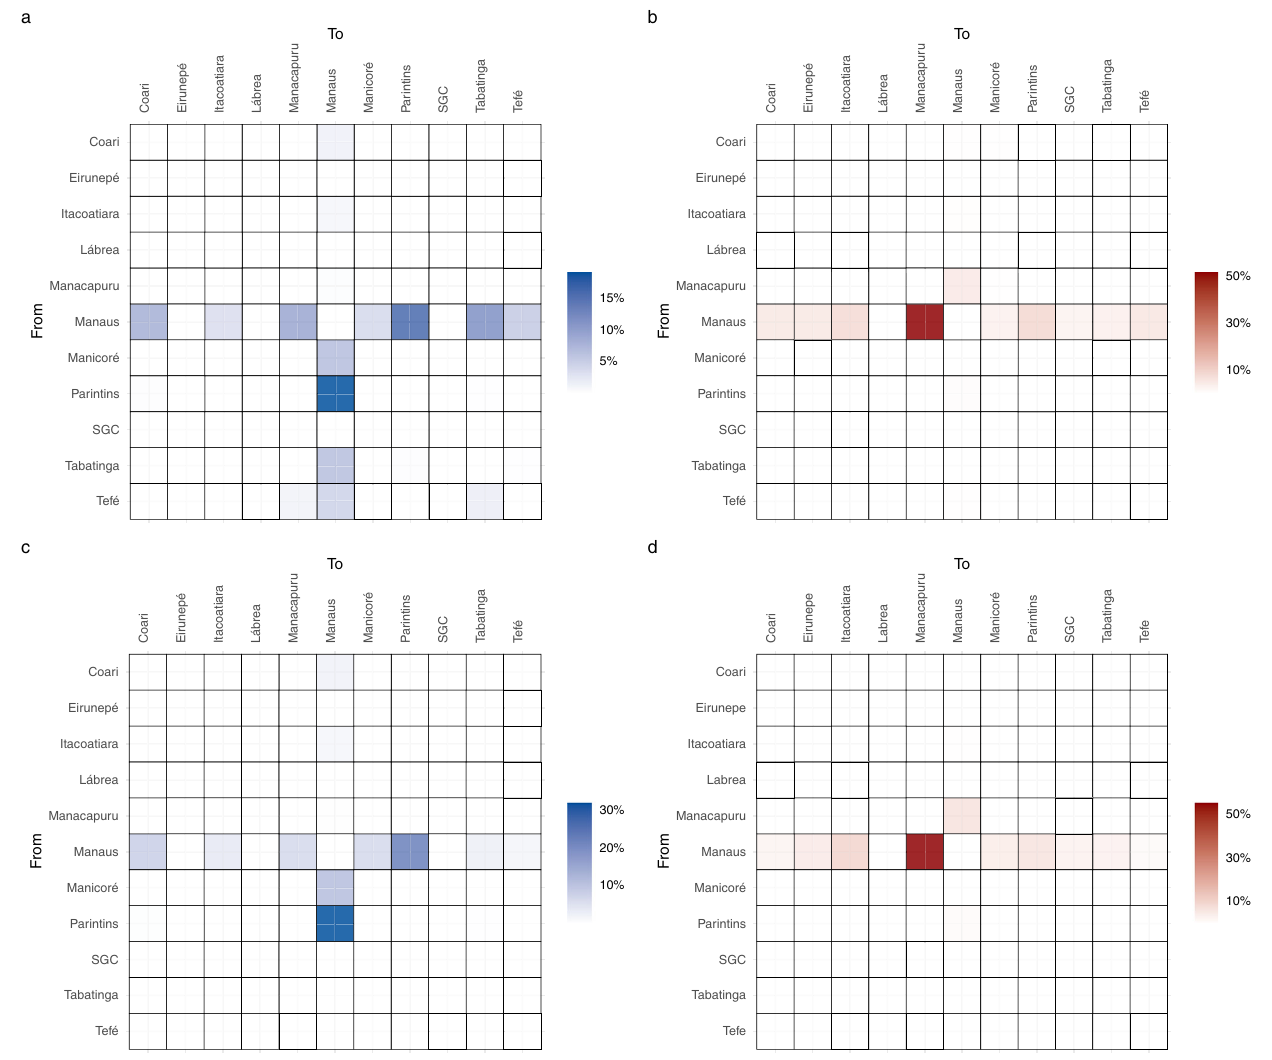
Fig.4|DisseminationofthemostprevalentDeltaandOmicronlineageswithin the Amazonas state. a – d Heatmap cells are colored according to the estimated numberofmigrationsbetweenAmazonianregionsforallDelta( a )andOmicron( b )